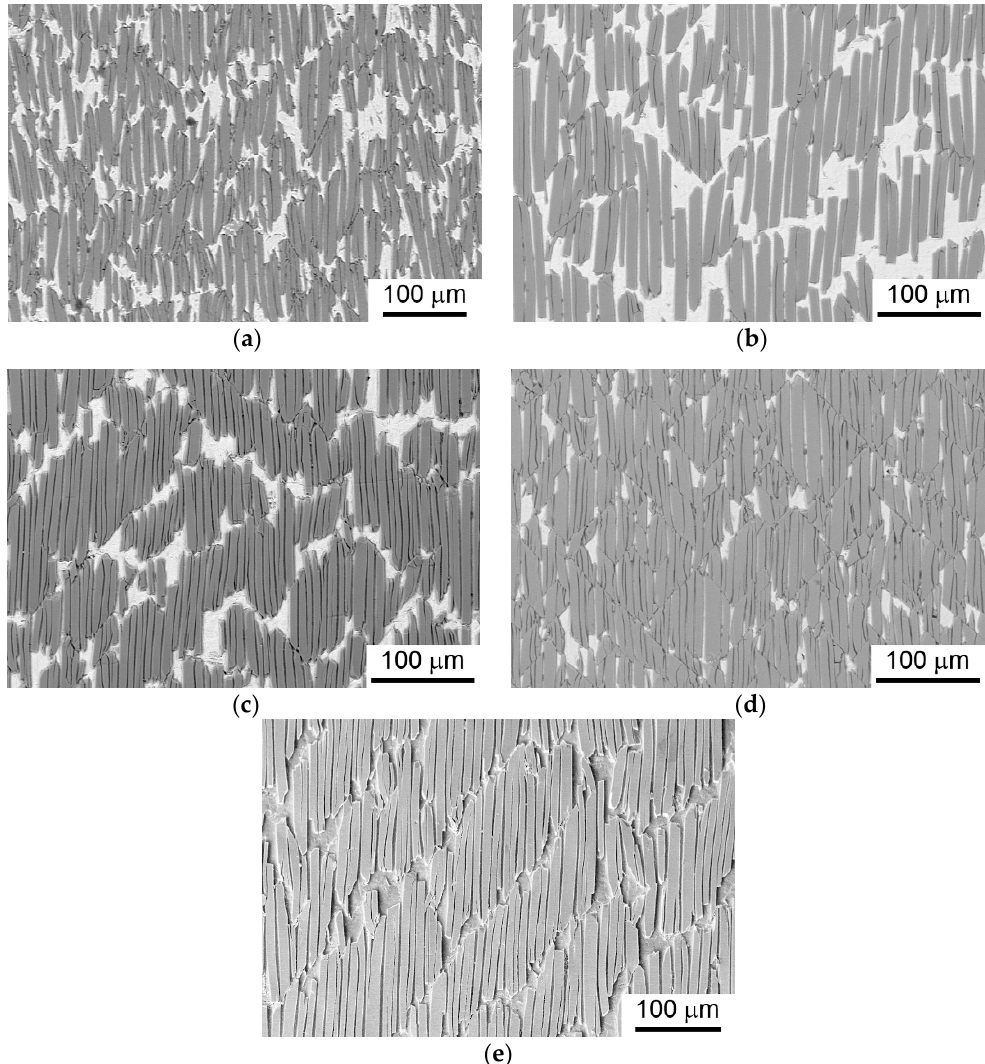
Figure 6. SEM micrographs of the ( a ) Ti 0.45 Al 0.55 N; ( b ) ML1; ( c ) ML2; ( d ) ML3 and ( e ) Ti 0.43 Al 0.45 Ta 0.12 N after uniaxial tension to fracture of the substrates.